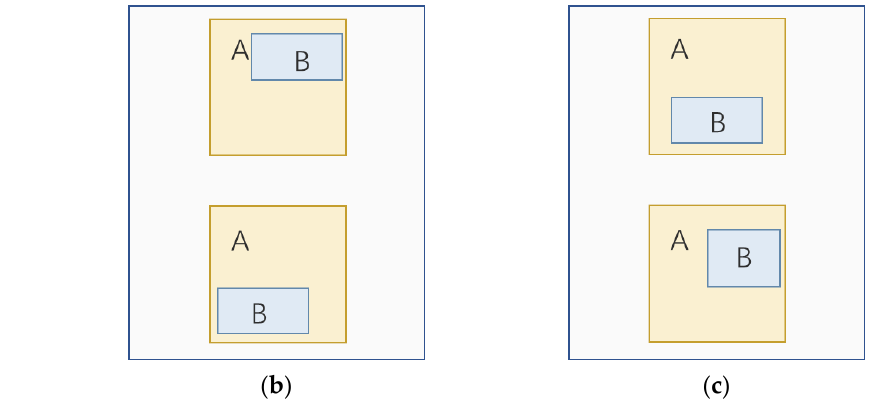
Figure 3. The shortcoming of IoU, A refers to the ground-truth box, and B refers to the predicted box: ( a ) the predicted box does not intersect with the ground-truth box; ( b ) the same predicted box is in different positions within the ground-truth box; ( c ) different predicted boxes with the same area in the ground-truth box.